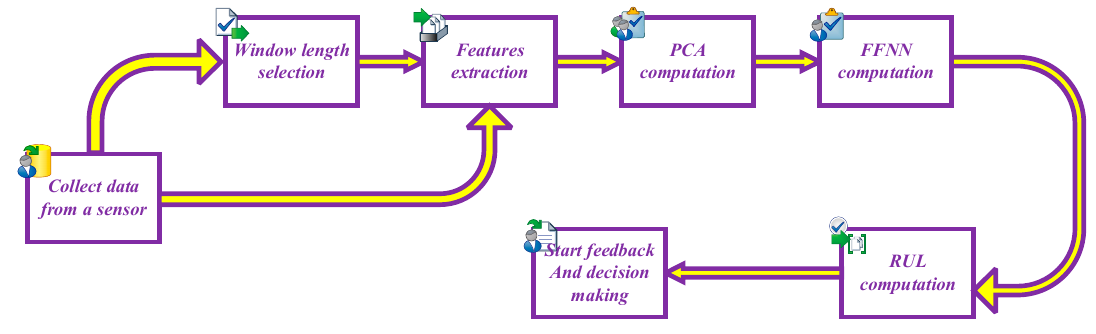
Figure 5. Block diagram of the proposed method.